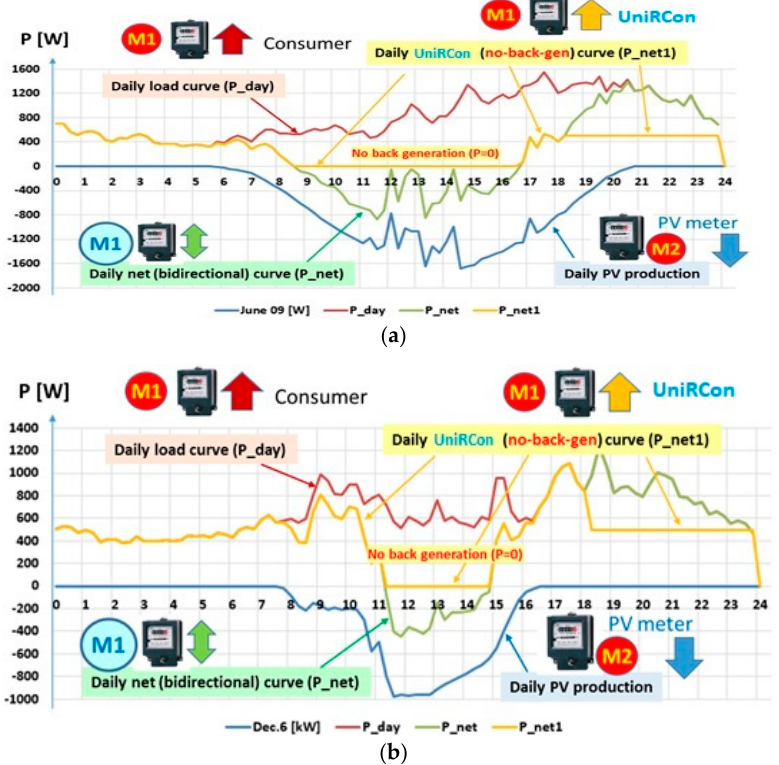
Figure 6. ( a ) Typical household electricity consumption, production and net-metered energy curves for one specific day in June 2016; ( b ) typical household electricity consumption, production and net-metered energy curves for one specific day in December 2016.